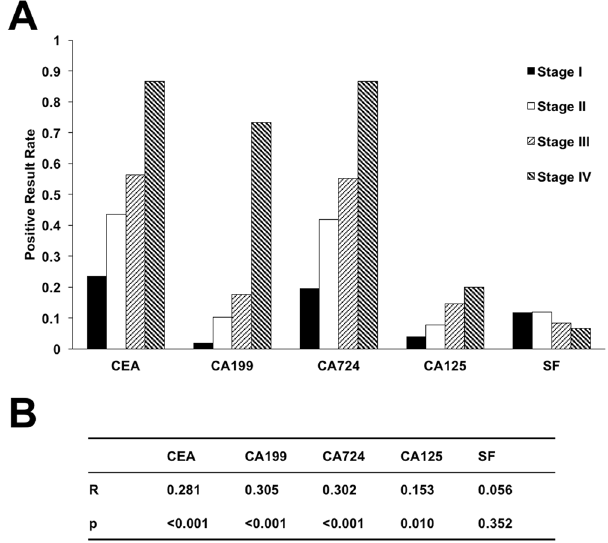
Figure 1. The correlation of the preoperative expression of serum tumor markers with pTNM staging. ( A ) The sensitivities of biomarkers in patients at different pTNM stages. ( B ) The correlation between preoperative serum tumor markers and the pTNM